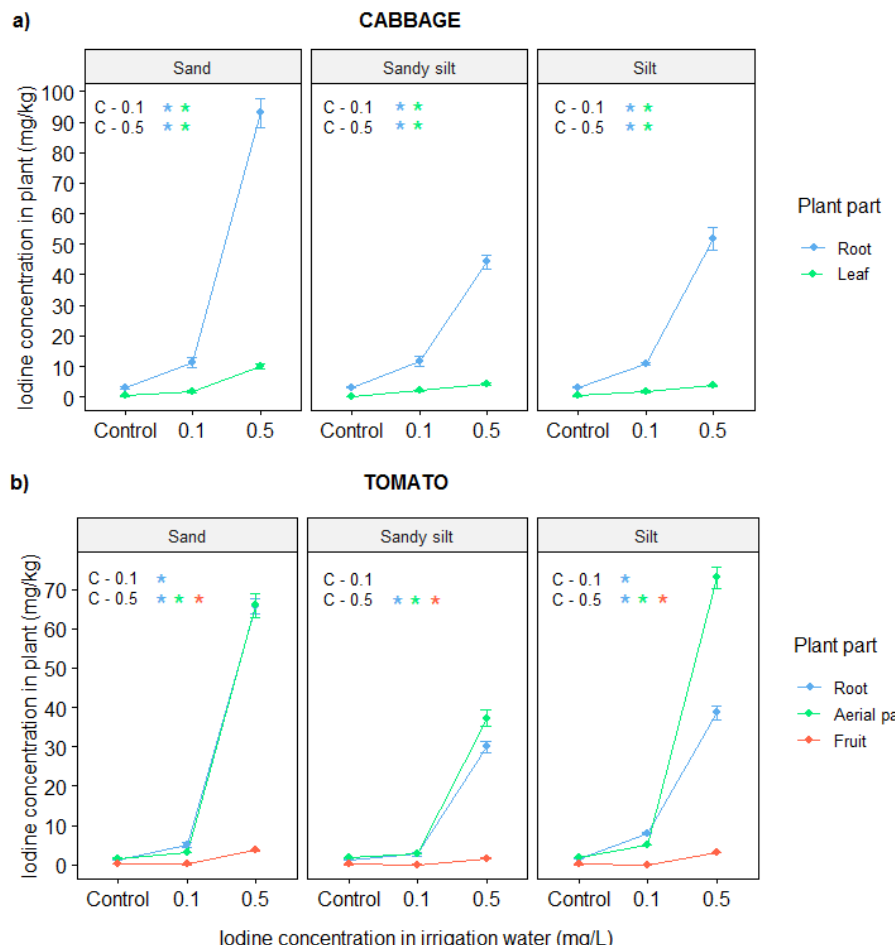
Figure 1. Iodine concentration (dry weight (DW)) in different parts of cabbage (a) and tomato (b) plants, cultivated in different soils (sand, sandy silt, silt), and irrigated with iodine containing (0.1 and 0.5 mg/L) irrigation water. Significant treatment effects are signed on the top left corner, * means p < 0.05 based on linear regression.